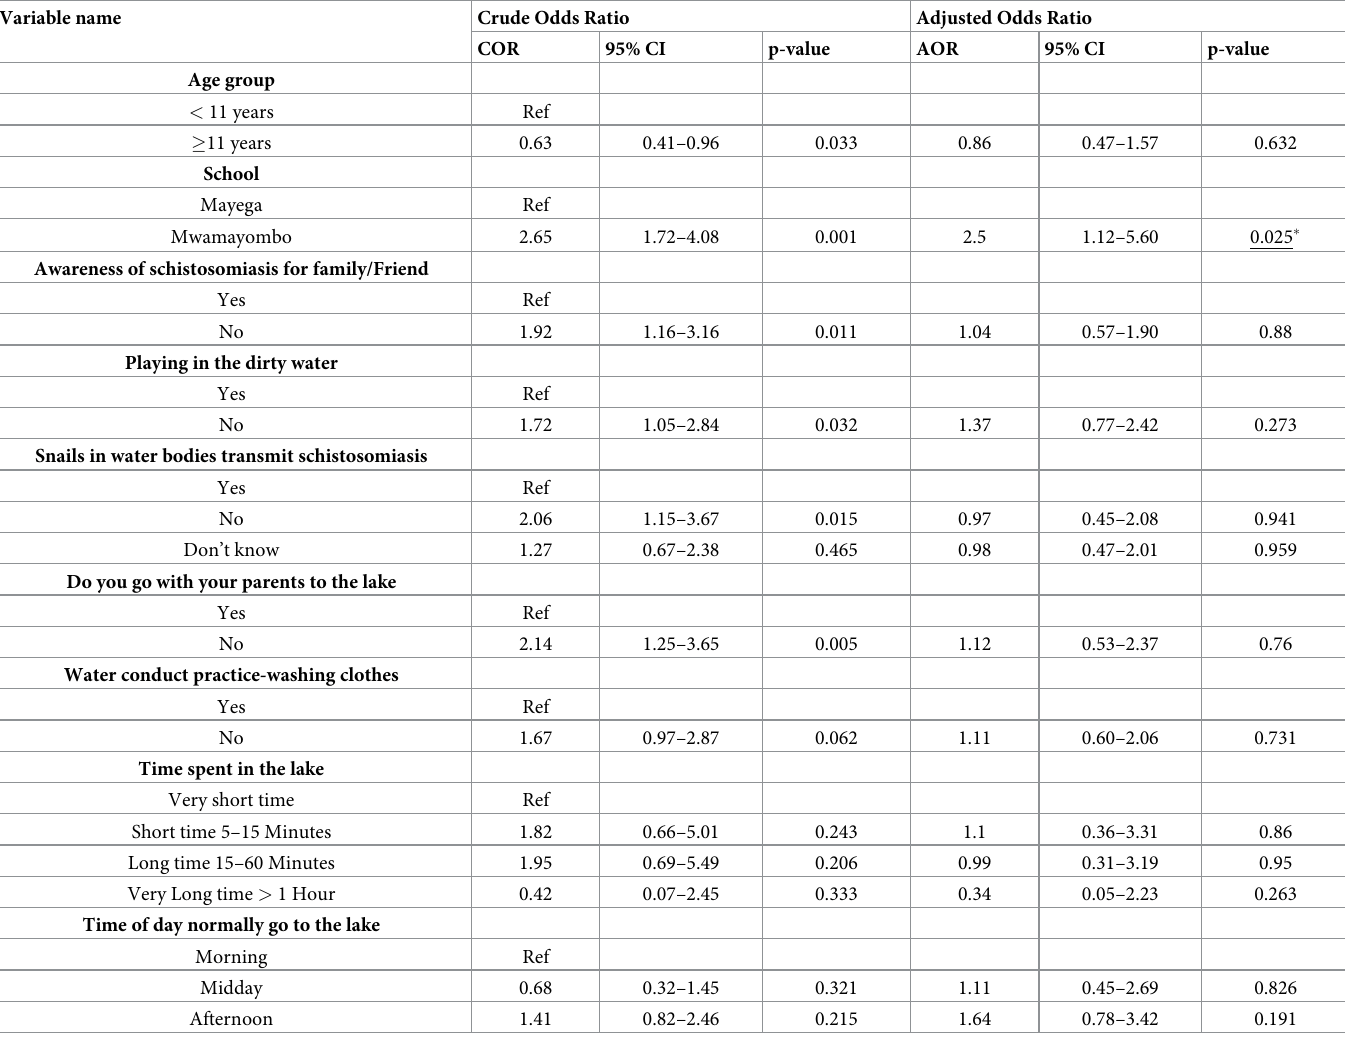
Table 5. Risk factors associated with S . mansoni infection among the participants. Variable